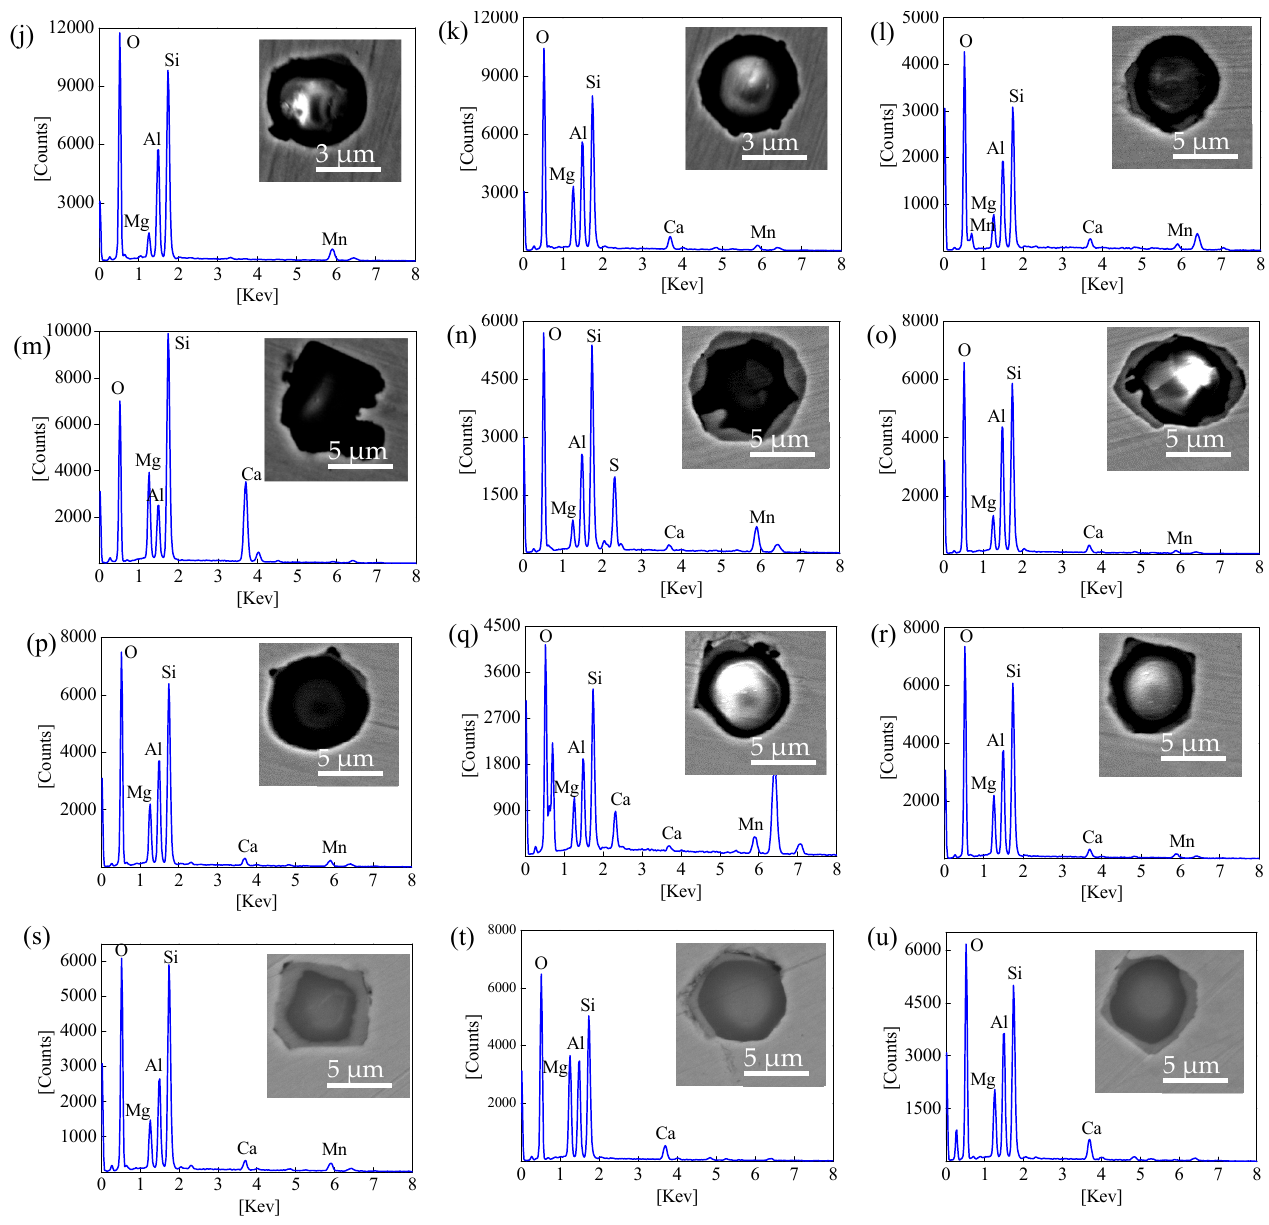
Figure 4. The typical inclusions in steel samples. 1 # : ( a – c ); 2 # : ( d – f ); 3 # : ( g – i ); 4 # : ( j – l ); 5 # : ( m – o ); 6 # : ( p – r ); 7 # : ( s – u ).